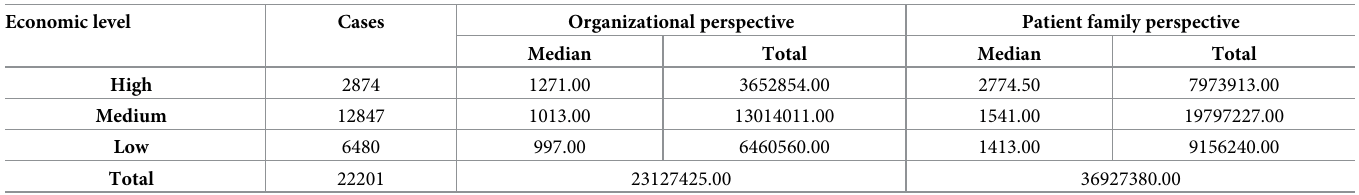
Table 4. Direct medical expenses of dengue fever cases from different perspectives (CNY). Economic